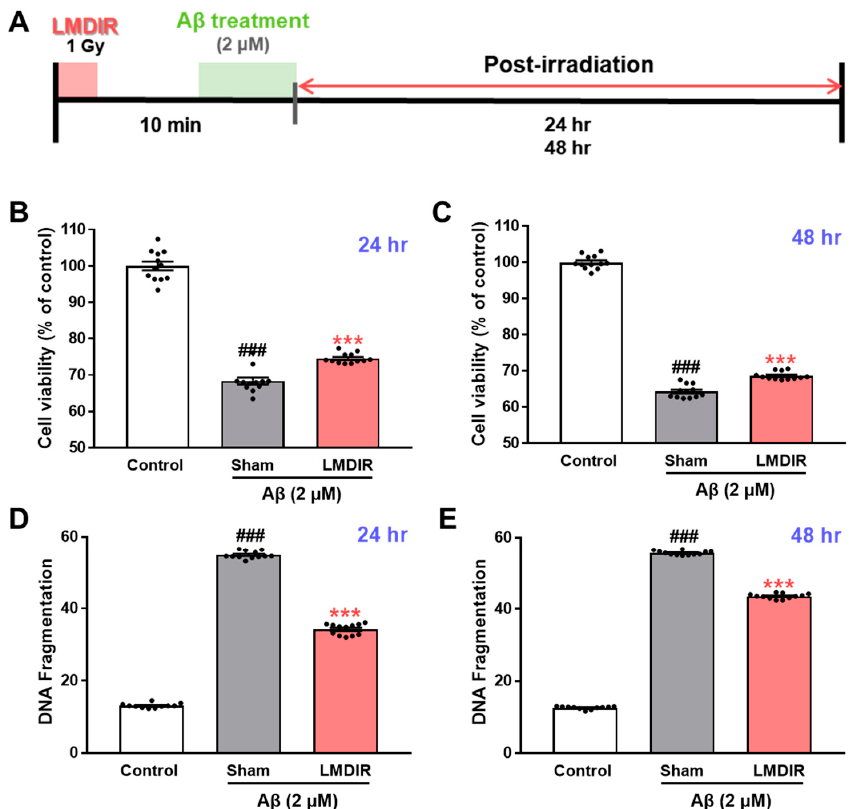
Figure 5. Direct neuroprotective effect of LMDIR against A β toxicity in cultured neuronal cells. ( A ) Outline of the experimental design. SH-SY5Y cells were exposed to LDIR (1 Gy), and then incubated with 2 µ M A β for 24 or 48 h. ( B , C ) Cell viability was measured using an MTT assay. The cell viability of the LMDIR- and A β -treated SH-SY5Y cells was significantly higher than that of the sham- and A β -treated SH-SY5Y cells 24 and 48 h after irradiation. ( D , E ) Cell death was evaluated by measuring DNA fragmentation using an ELISA kit. The DNA fragmentation in LMDIR- and A β -treated SH-SY5Y cells was significantly lower than that of sham- and A β -treated SH-SY5Y cells 24 h and 48 h after irradiation. Data are presented as mean ± SEM. ### p < 0.001: control versus sham-exposed SH-SY5Y cells. *** p < 0.001: sham-exposed SH-SY5Y cells versus LMDIR-exposed SH-SY5Y cells. LMDIR, low–moderate dose ionizing radiation; A β , amyloid- β .